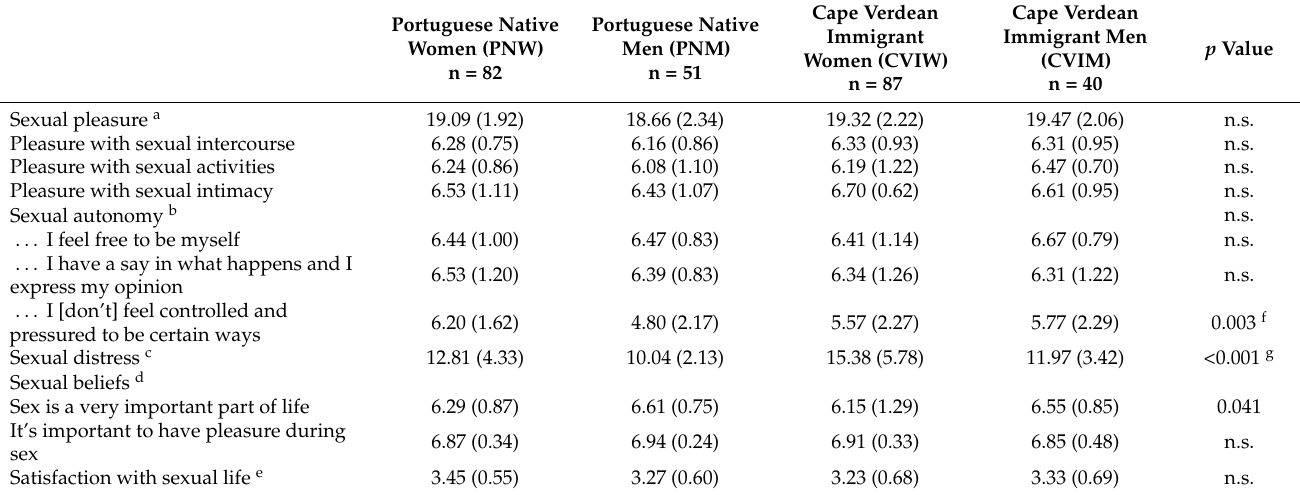
Table 2. Sexual pleasure, sexual autonomy, and associated